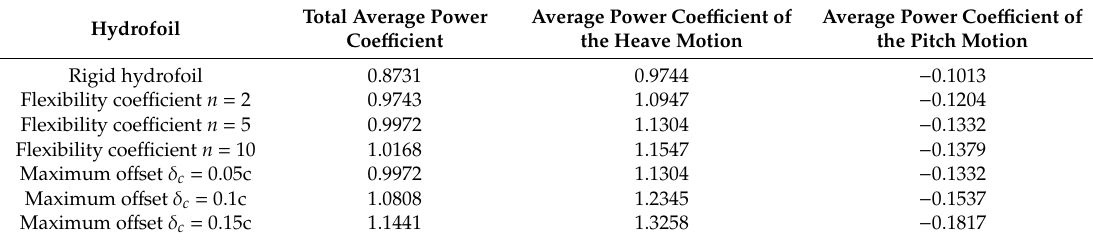
Table 3. Average power coe ffi cient of hydrofoil under di ff erent flexibility coe ffi cients and trailing edge o ff sets.